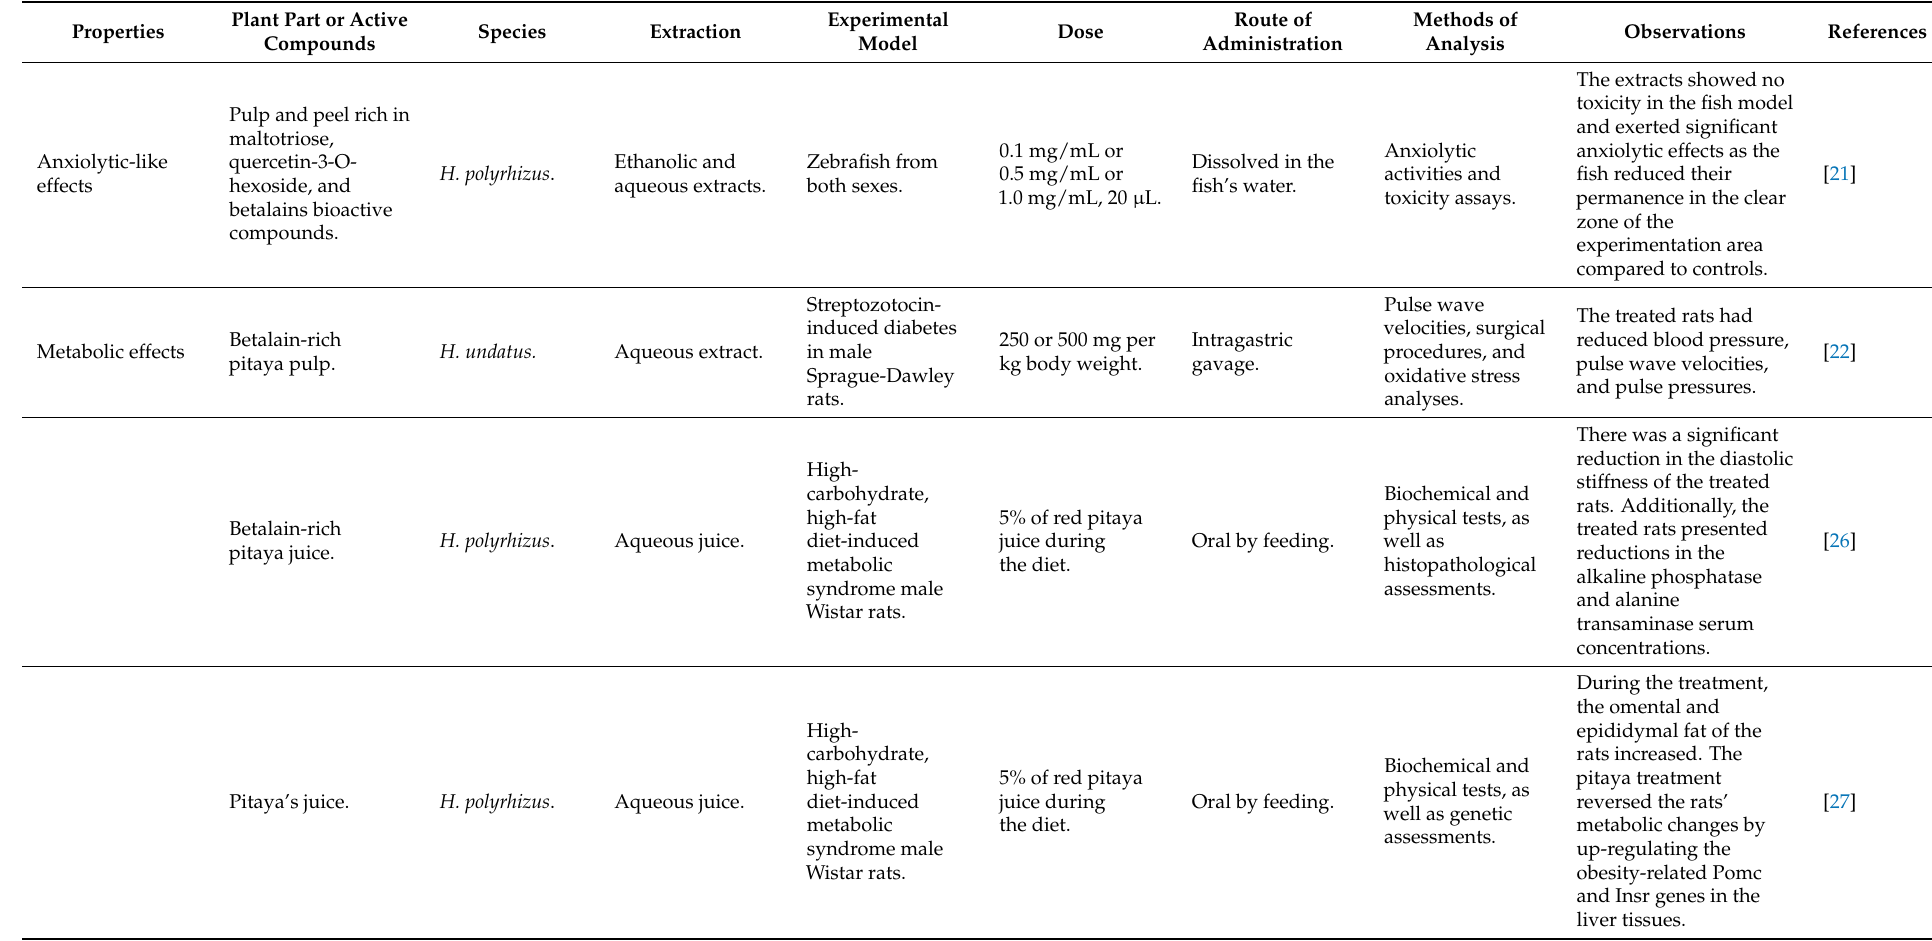
Table 1. In vivo biological and pharmacological activities of various pitaya extracts and pure